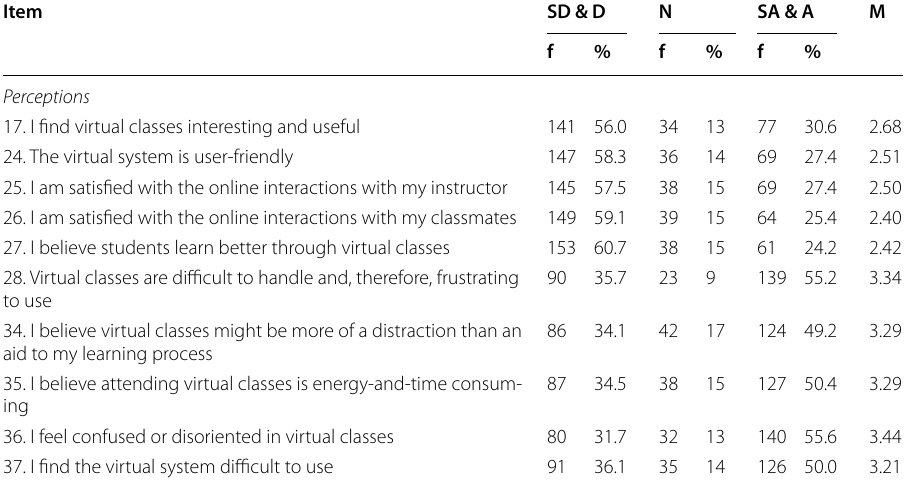
Table 10 Frequency, percentage, & mean scores of responses to APPRSQ (perceptions) Item SD & D N